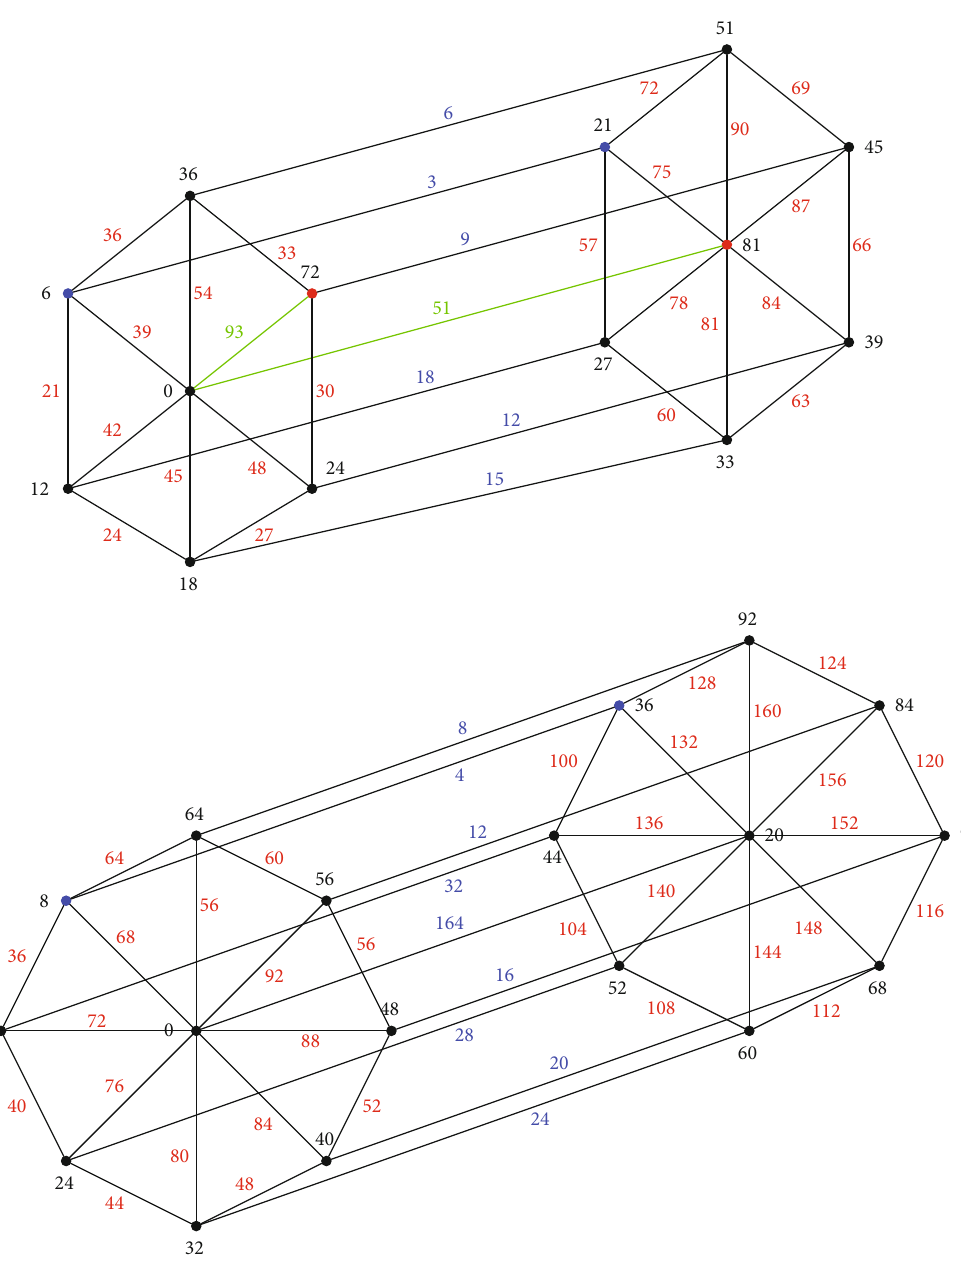
− graceful labeling and P ð W Figure 10: P ð W 6 Þ with an edge 3